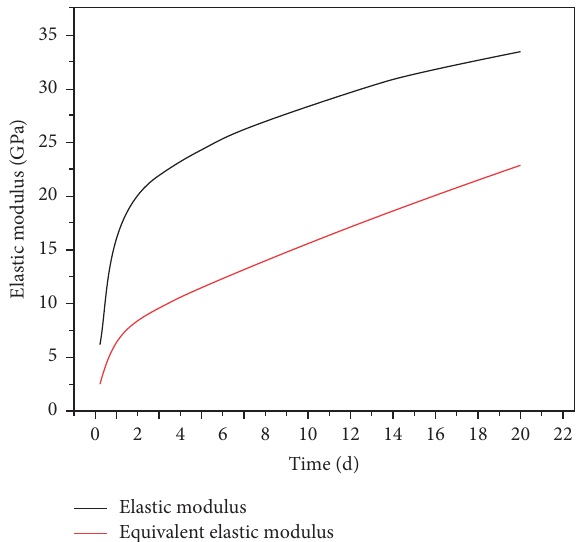
Figure 4: Modulus of elasticity of shotcrete.